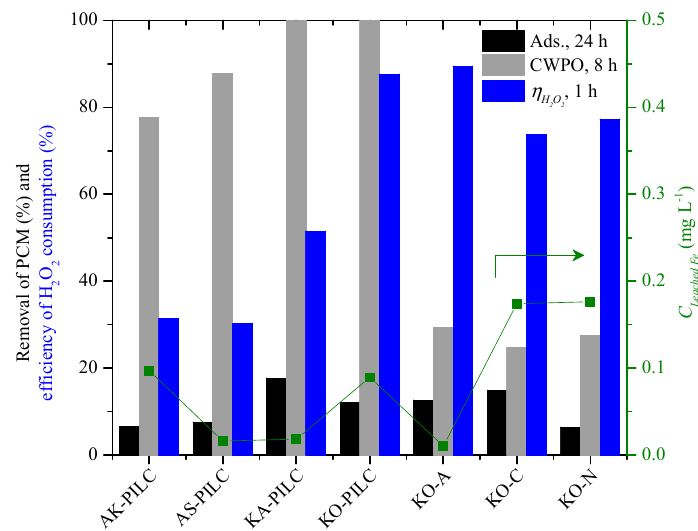
Figure 6. Pollutant removal by CWPO and by pure adsorption after 8 and 24 h, respectively; and H 2 O 2 consumption efficiency and leached iron after 1 and 24 h of time of reaction, respectively in CWPO runs. Operating conditions: C PCM = 100 mg L − 1 , C H and T = 80 °C.